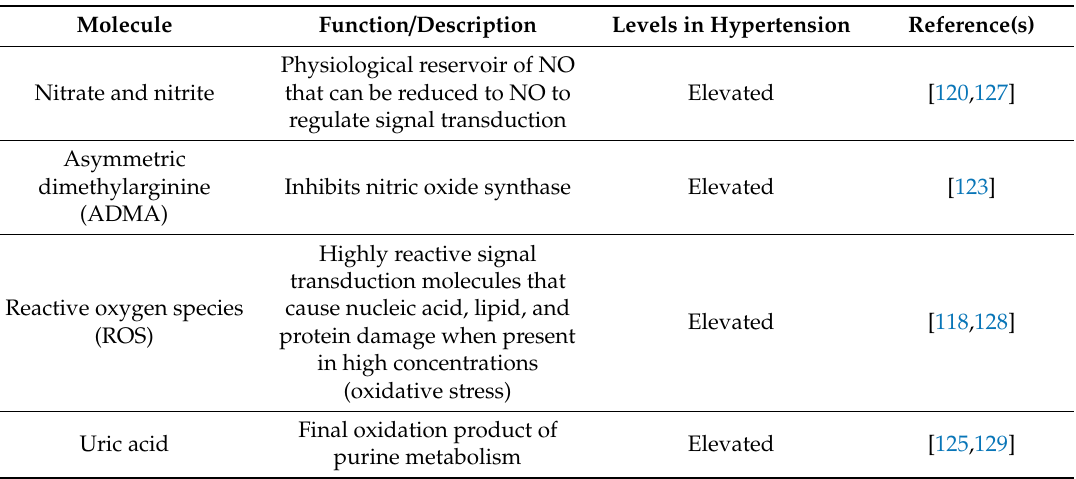
Table 4. Molecules used as biomarkers of